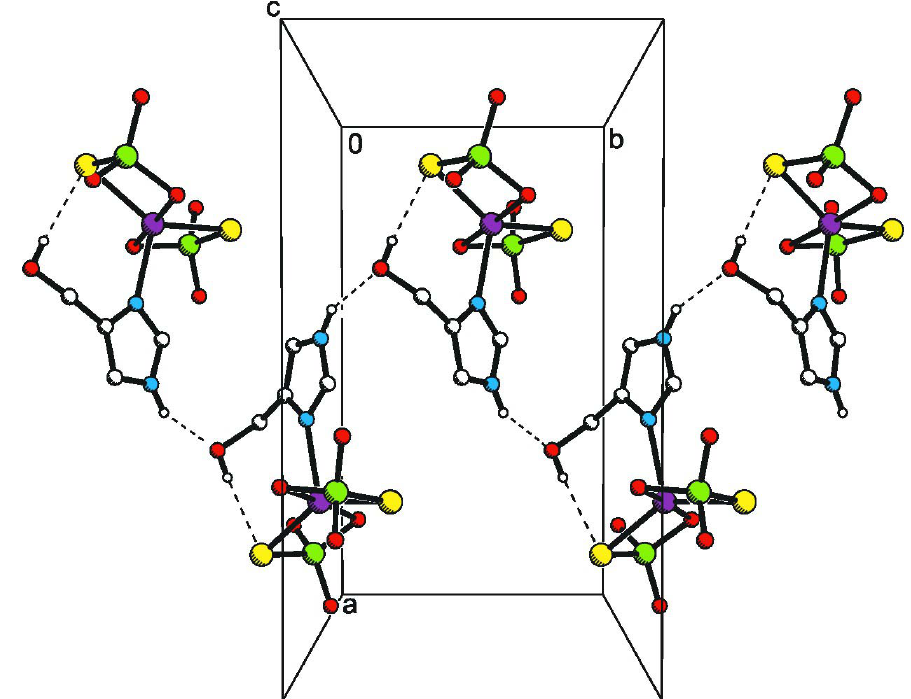
Figure 2 A view of one-dimensional chains of molecules linked by hydrogen bonds along the c axis. All t Bu groups have been omitted for clarity. Hydrogen bonds are indicated with dashed